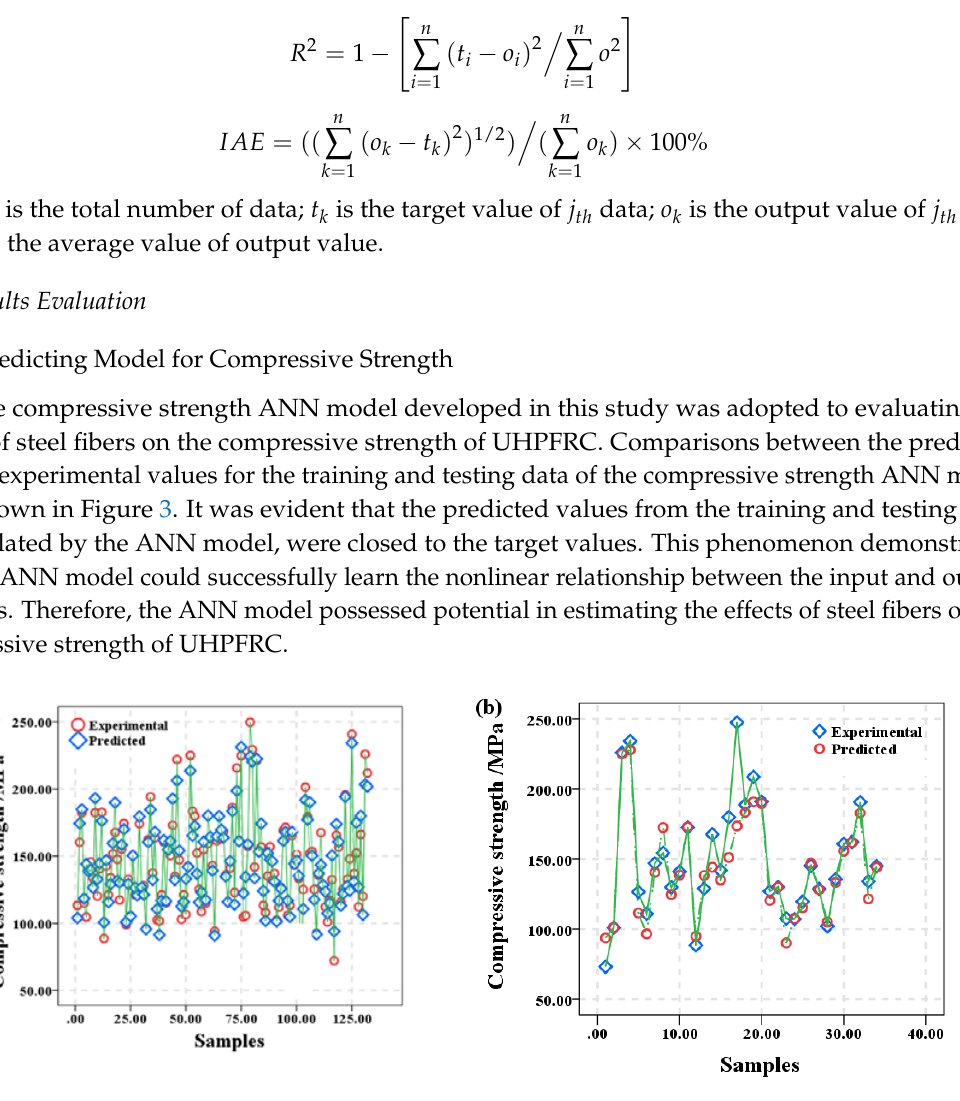
Figure 3. Comparison of predicted values from compressive strength ANN model with experimental results: ( a ) Training data, ( b ) Testing data. The figures show that the comparison between the target values and predicted values of testing and training data from experiments and compressive strength ANN model, the horizontal axis denotes number of training or testing data, and the vertical axis denotes the compressive strength. It was obvious that the predicted values accord with the target values. The input layer weights (ILW), input layer bias (ILB), hidden layer weights (HLW), and hidden layer bias (HLB) of the compressive strength ANN model are given by Equations (14)–(17),